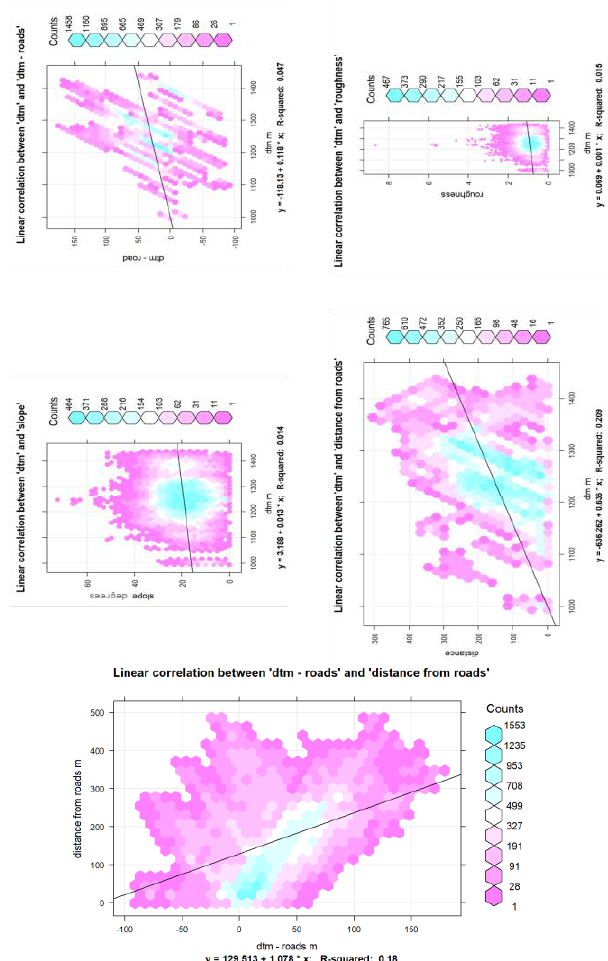
Figure 3. Scatterplot to visualize large dataset.